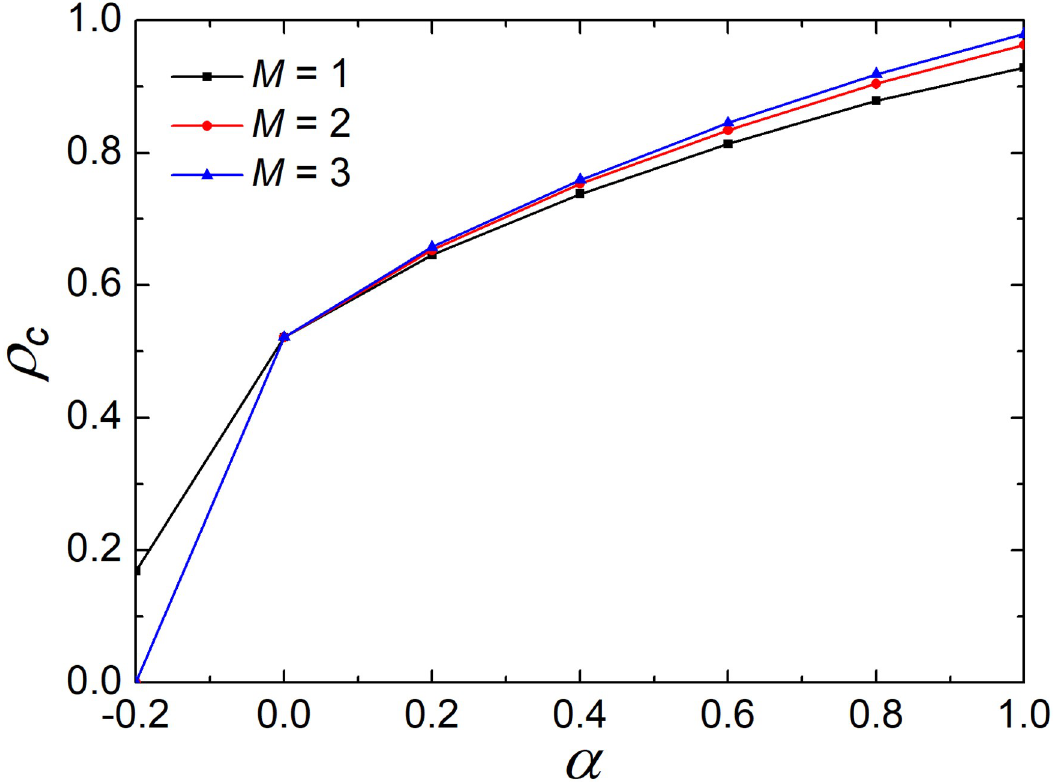
Fig 6. Frequency of cooperators depends on α for the different values of M when r = 4. It is obvious that all the curves monotonically increase, which means that the memory length can promote cooperation but the promotion effect gradually weakens.